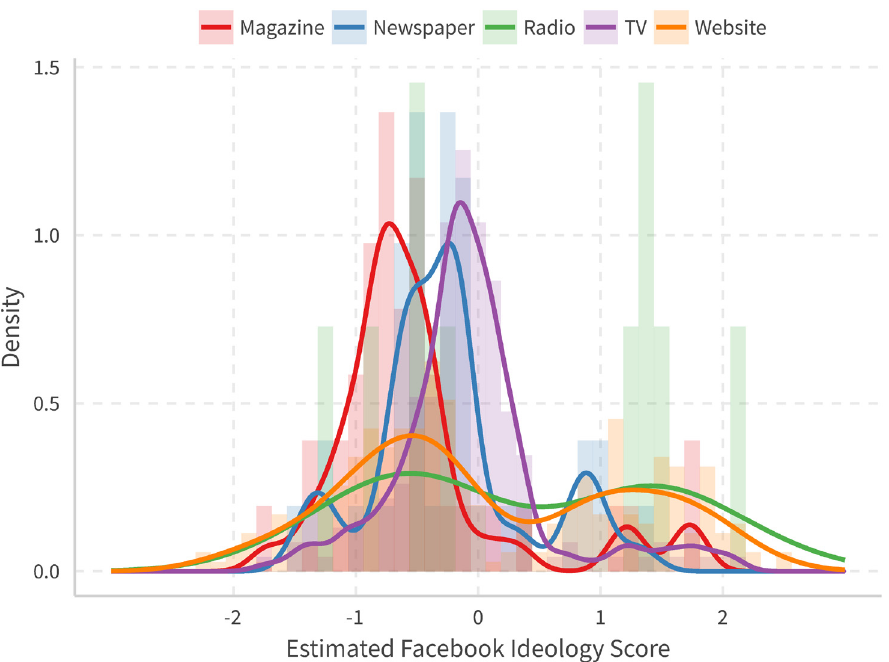
Fig 4. Histogram and density for different media page